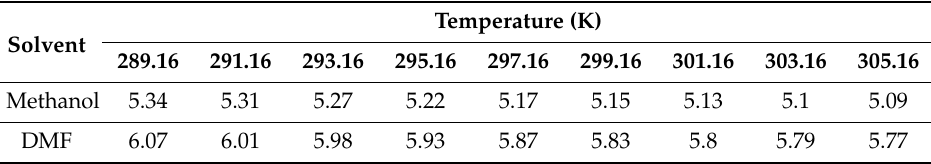
Table 2. Complex stability constants (log K values) associated to the complex formation of 1 with 6 in methanol or the DMF solvent determined for different temperatures. Solvent